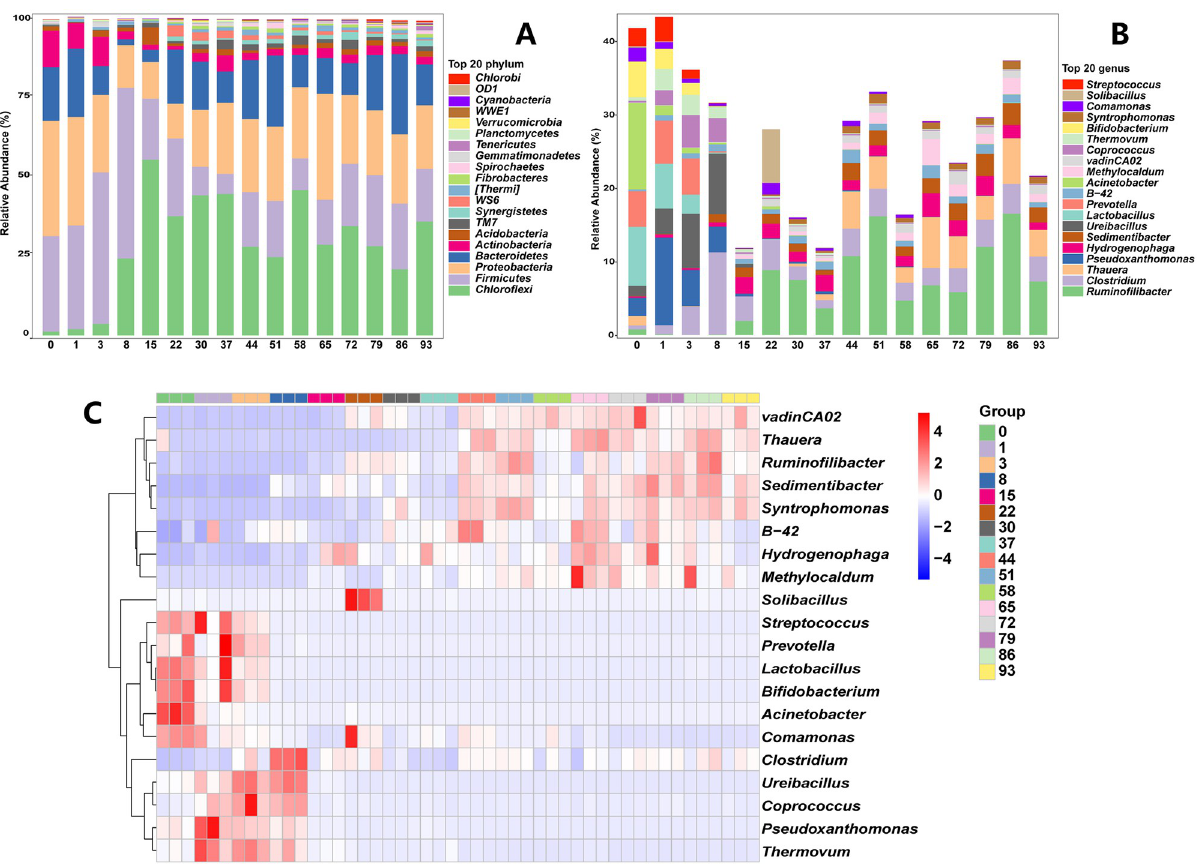
Fig 5. Changes in bacterial phylum and genus level and heatmap of top 20 genus in sample in ectopic fermentation of dairy